Question: Write a single sentence explaining what this figure depicts.
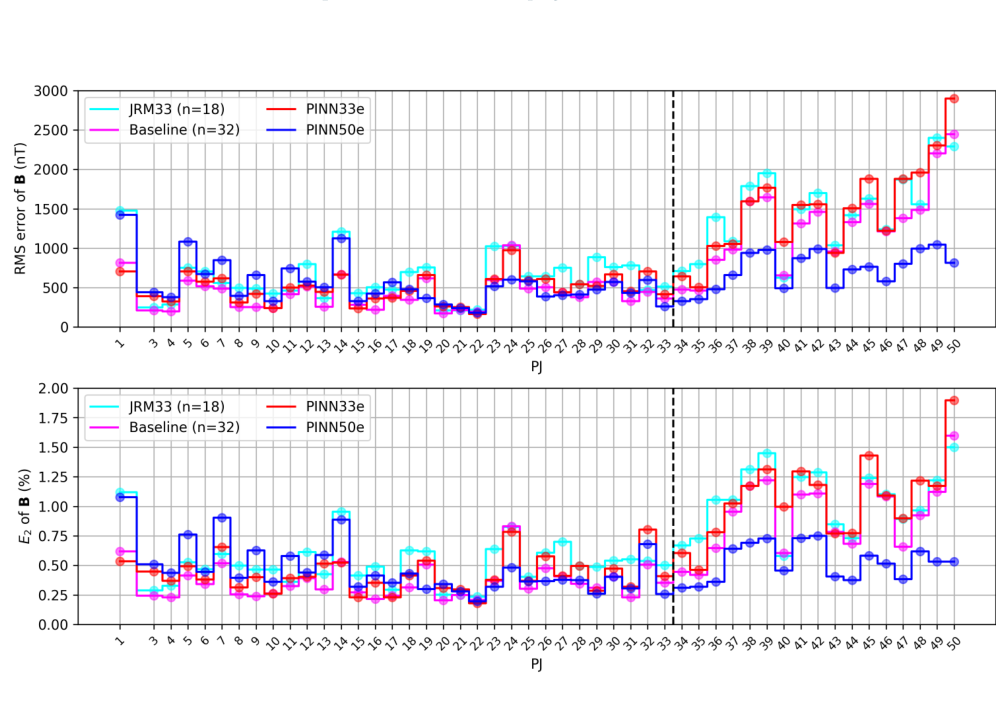
Answer: Orbital comparison of the discrepancy between various reconstructions of Jupiter’s